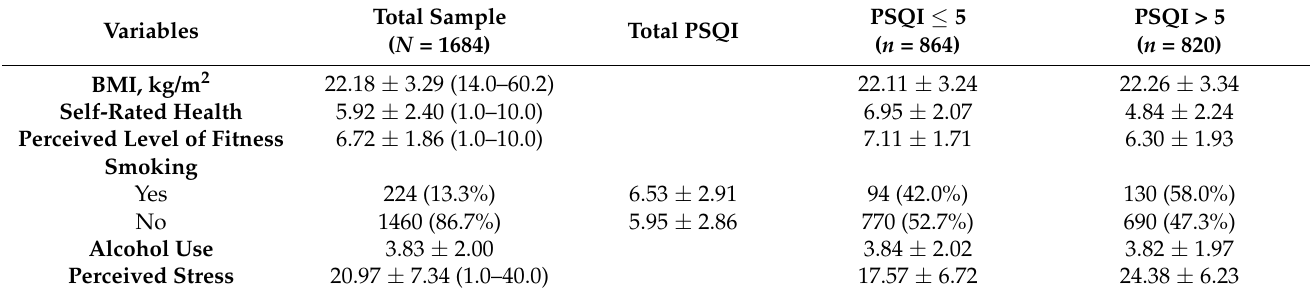
Table 2. Descriptive characteristics of health indicators stratified by PSQI classification.